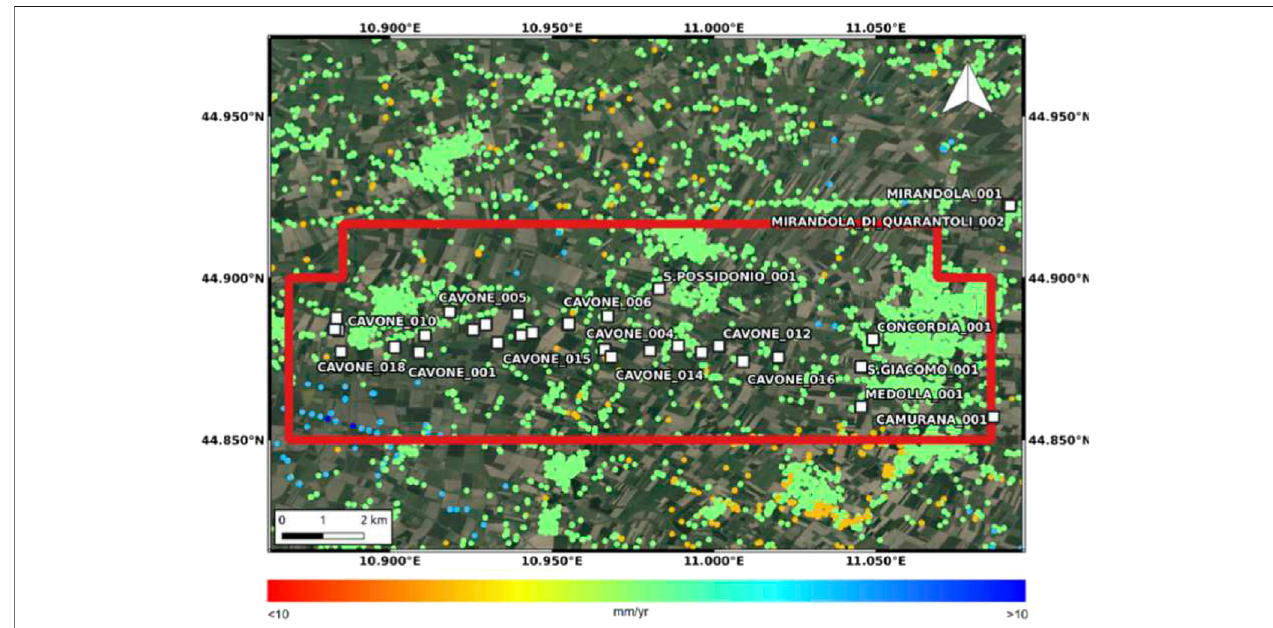
FIGURE 9 | Sentinel-1 InSAR Line-of-Sight (LoS) velocity map. The red polygon represents the Mirandola concession area as it was in 2018 – 2019. The white squares indicate the oil wells.